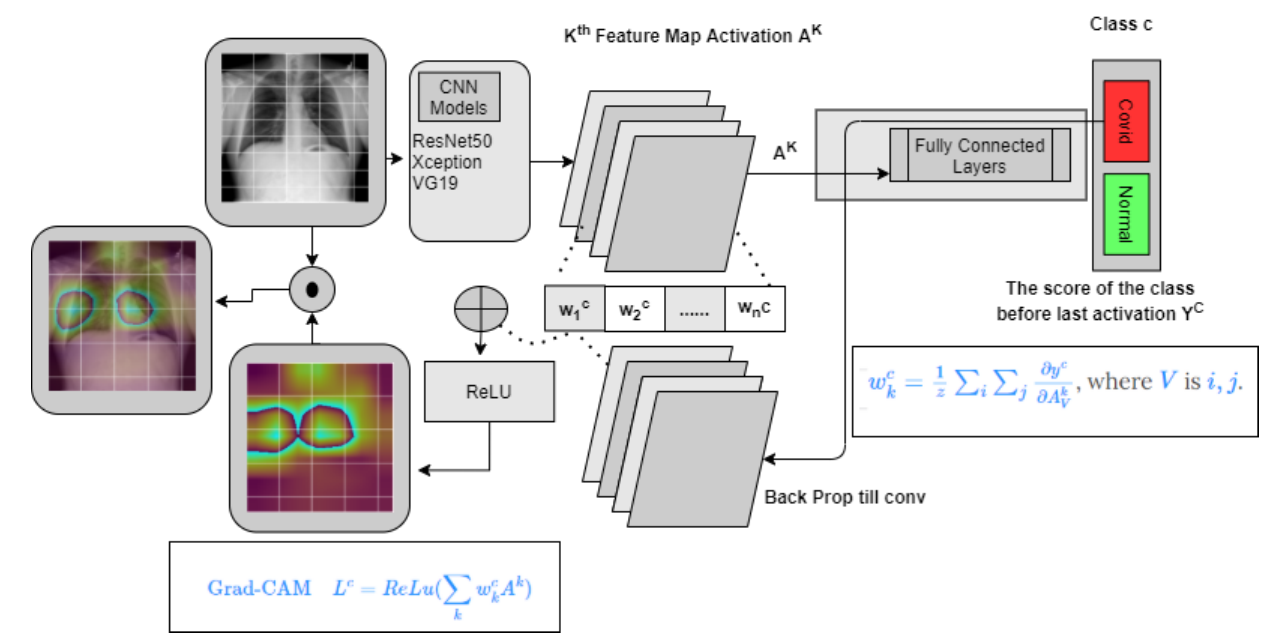
Figure 8. The complete process for Gradcam analysis for COVID and non-COVID classes. For the four classes, the same architecture is applied except the output class is COVID, Normal, Lung Opacity, and non-COVID viral